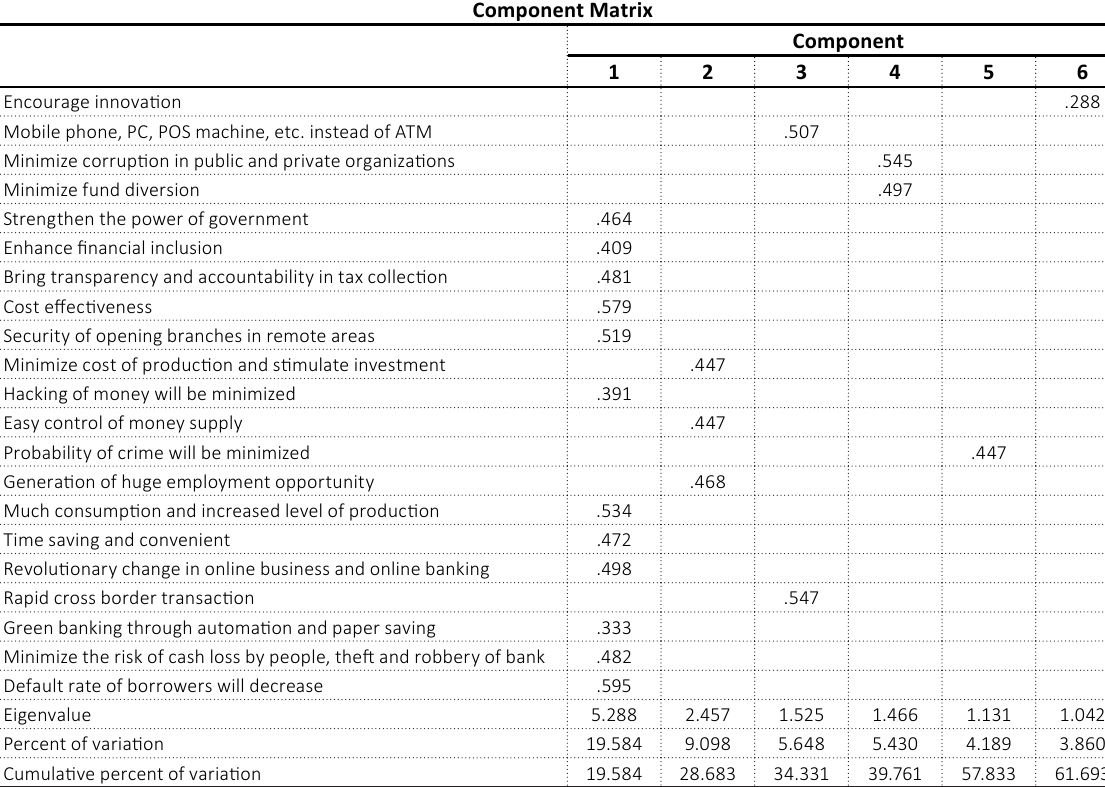
Table A1. Prospects for instigating full-fledged e-money in Bangladesh